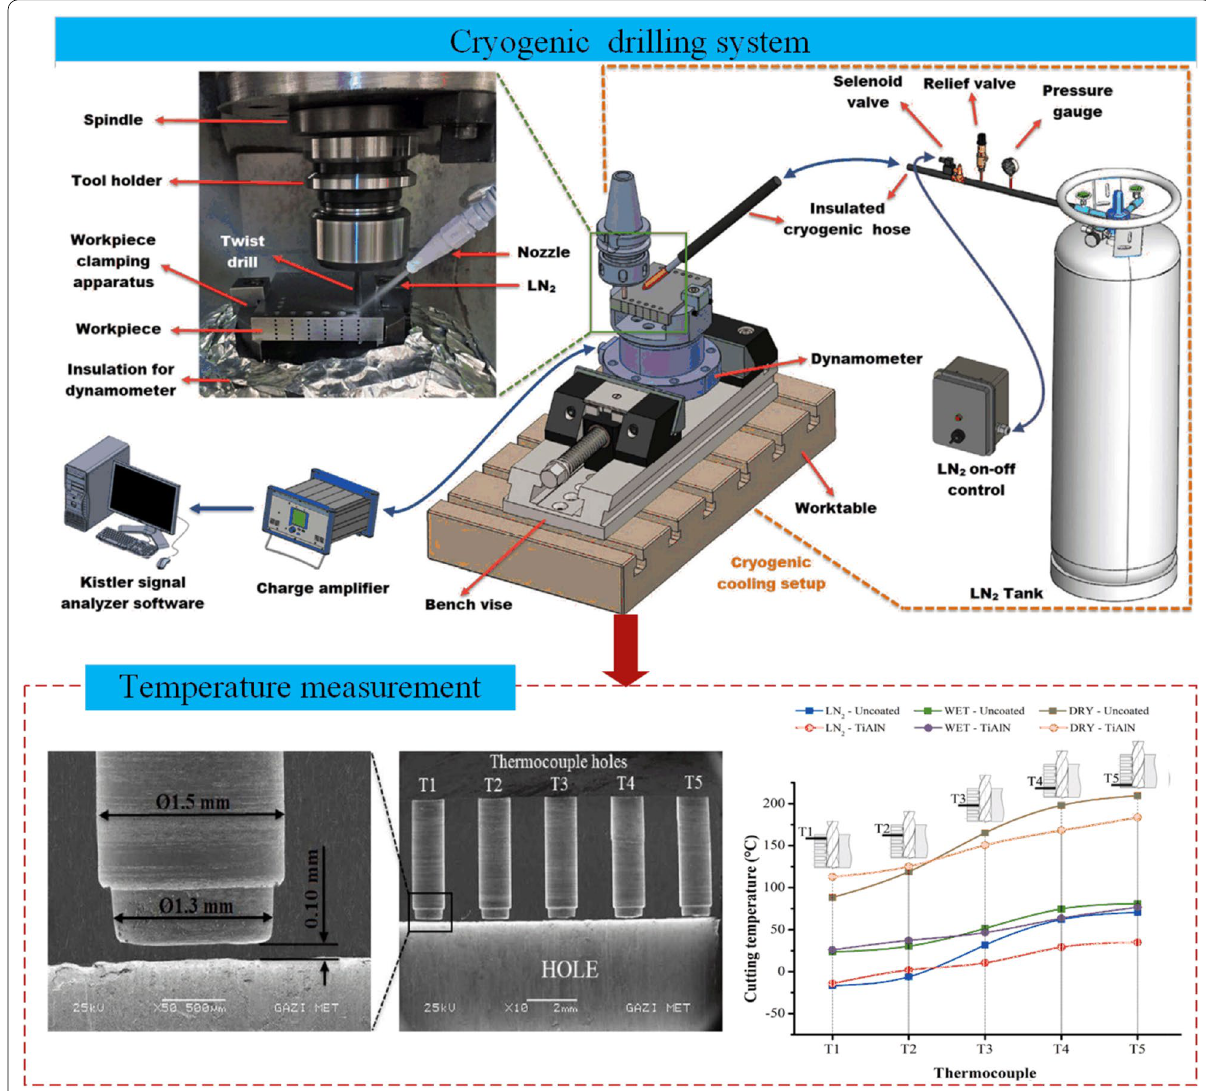
Figure 33 Cryogenic drilling system and drilling temperature values under different machining condition